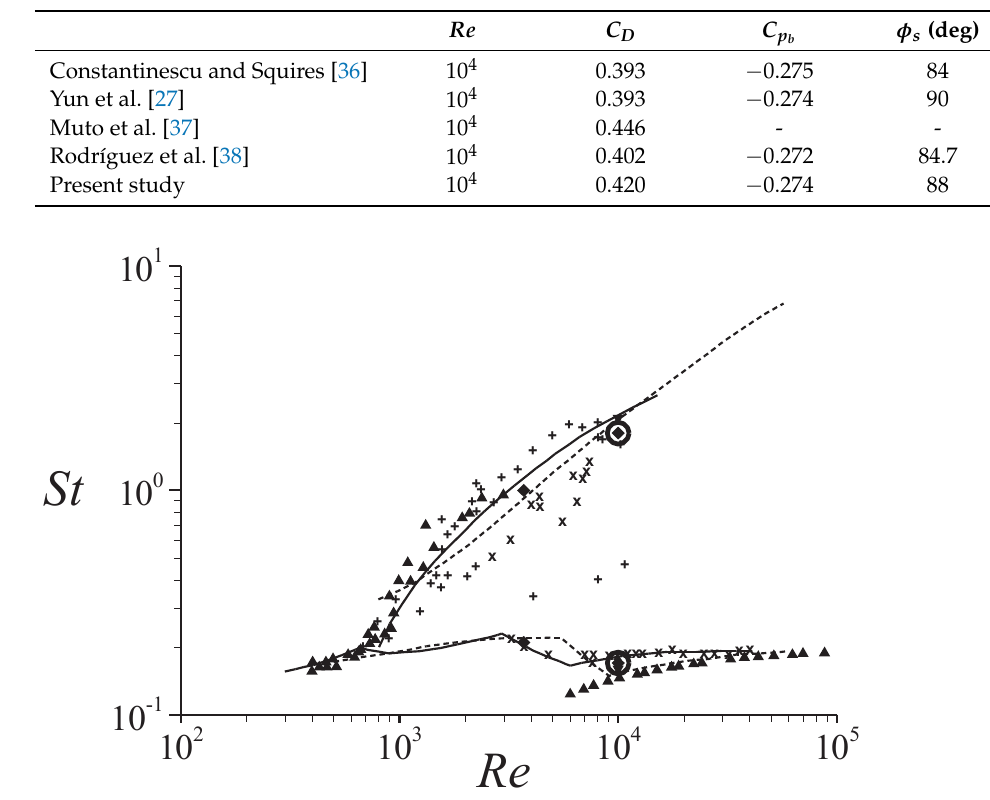
Figure 4. Shear layer and wake frequencies of the flow over a sphere at different Reynolds